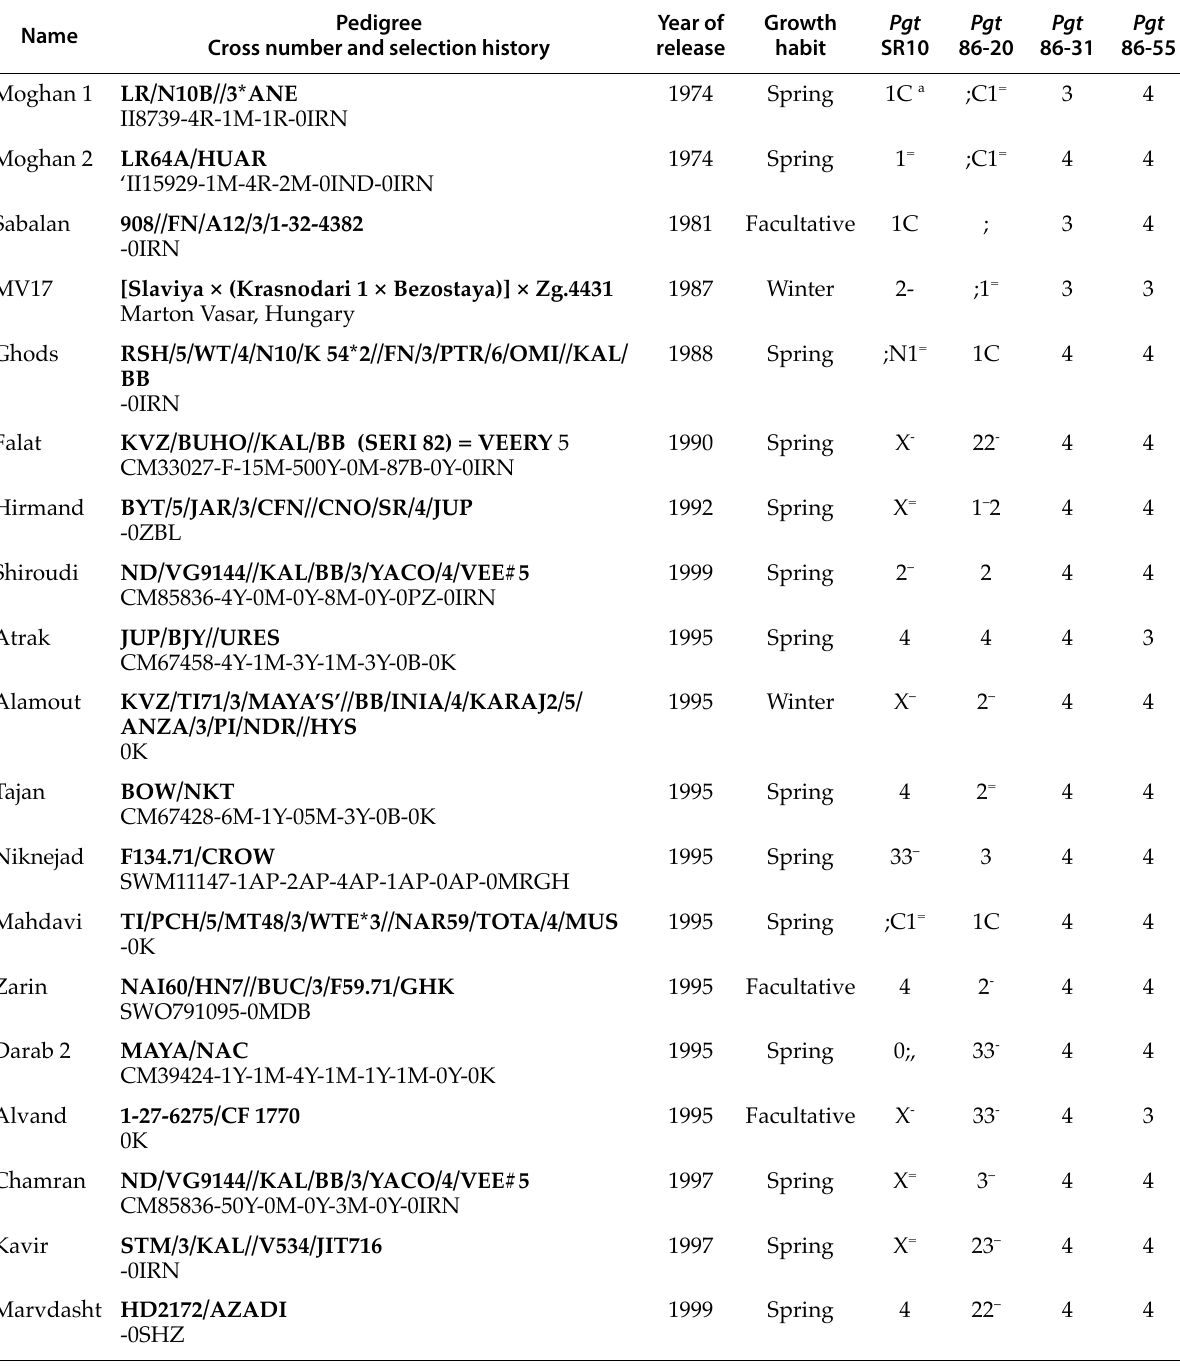
Table 6. Name, pedigree, year of release, country of origin and growth habit of 29 Iranian wheat cultivars evaluated for seedling resistance to four Puccinia graminis f. sp. tritici collections at seedling